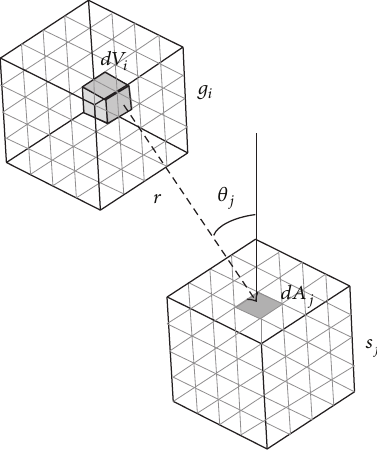
Figure 1: The schematic of volume and surface